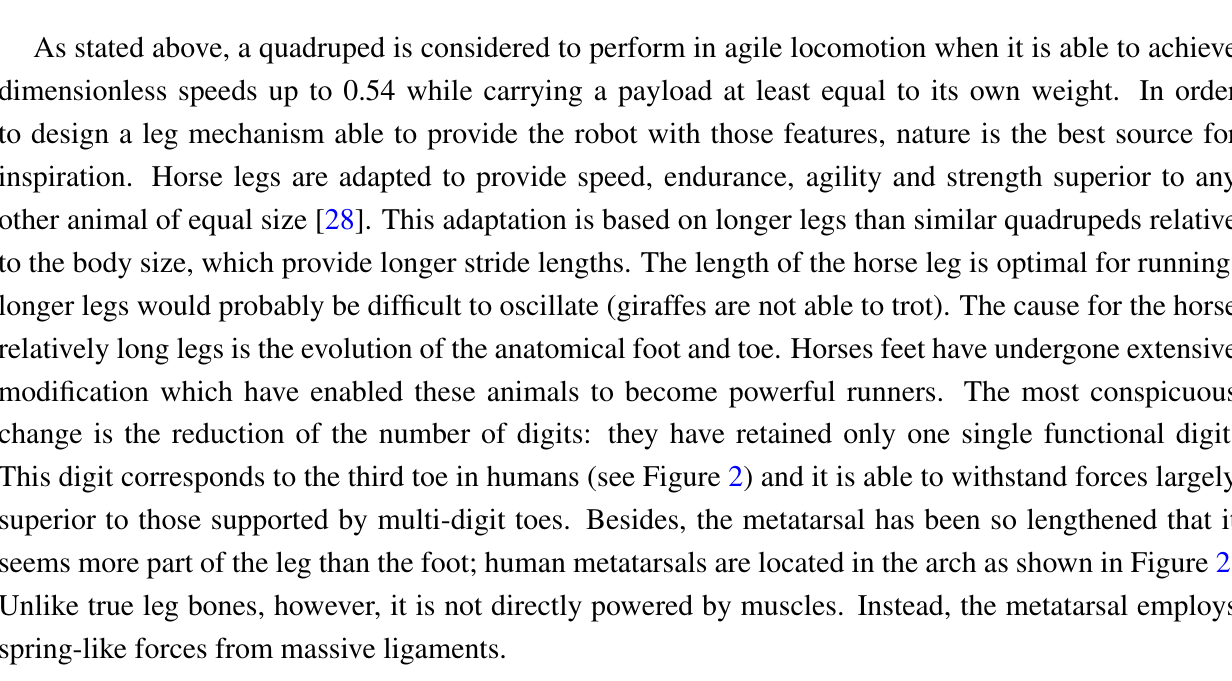
Figure 2. Comparison of horse foot and human foot